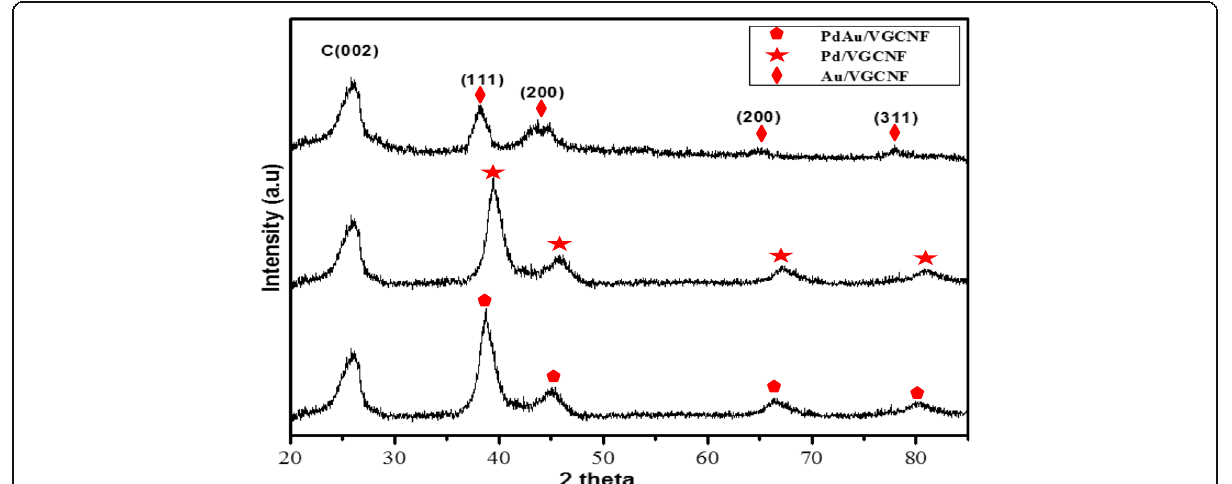
Fig. 1 Diffractograms of the different electrocatalysts Pd 1 Au 1 /VGCNF, Pd/VGCNF, and